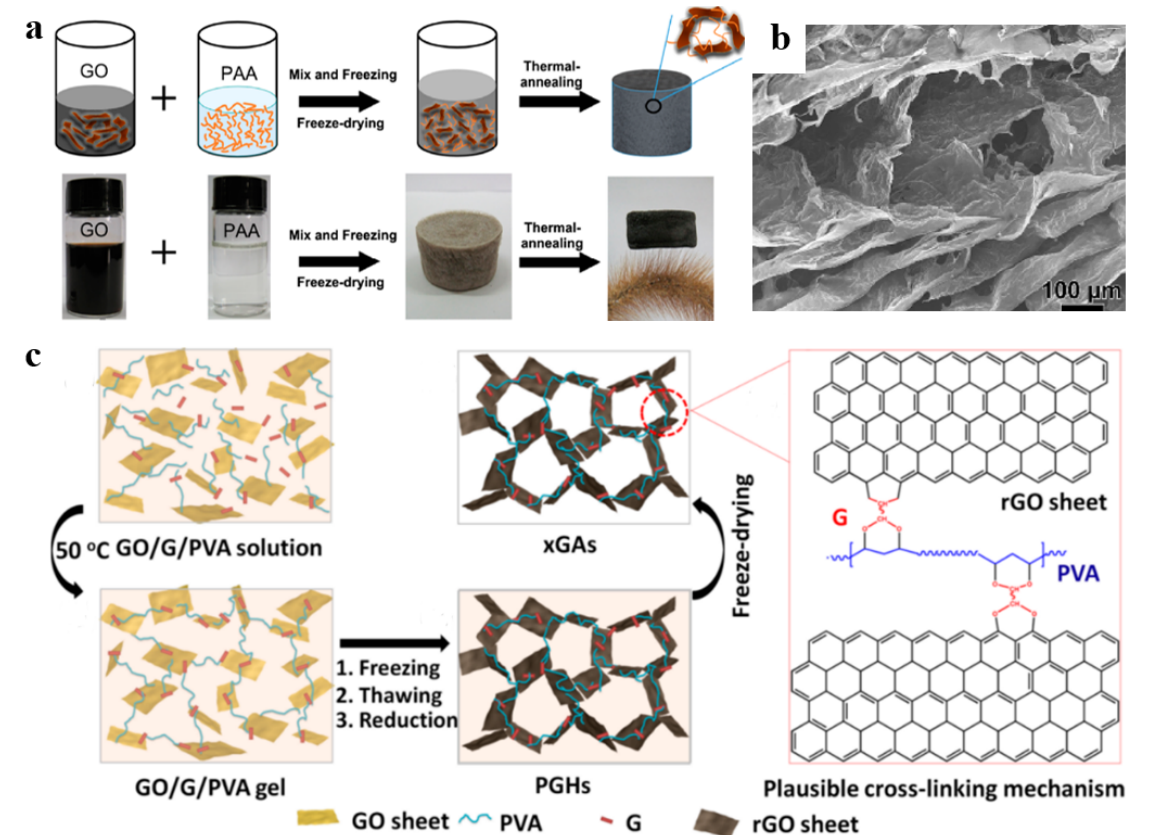
Figure 6. ( a ) Schematic illustration of the fabrication process of RGO/PI aerogel. ( b ) The SEM image of RGO/PI aerogel. Reproduced with permission from [71]. ( c ) Schematic showing the formation of graphene/PVA composite aerogels. Reproduced with permission from [74].